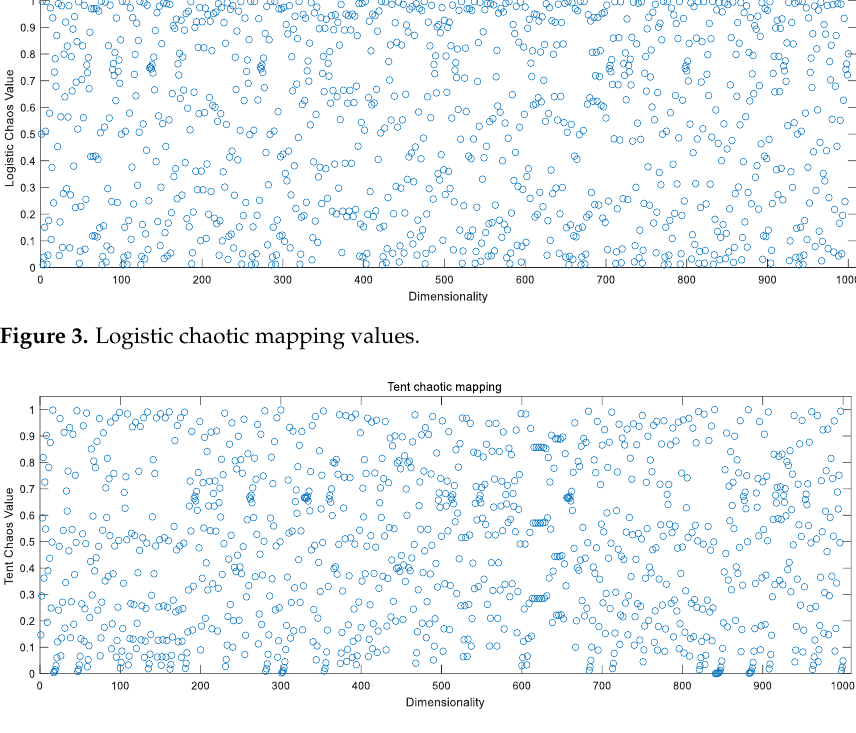
Figure 4. Tent chaotic mapping values.